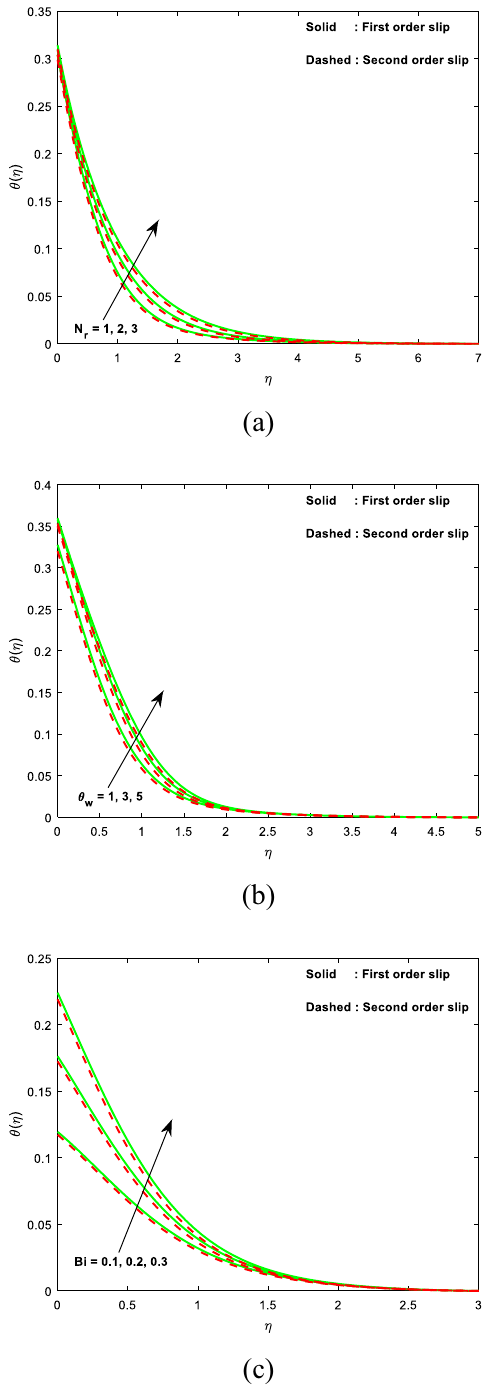
Figure 4. Curves of temperature with the variant in ( a ) N r ( b ) θ w ( c ) Bi